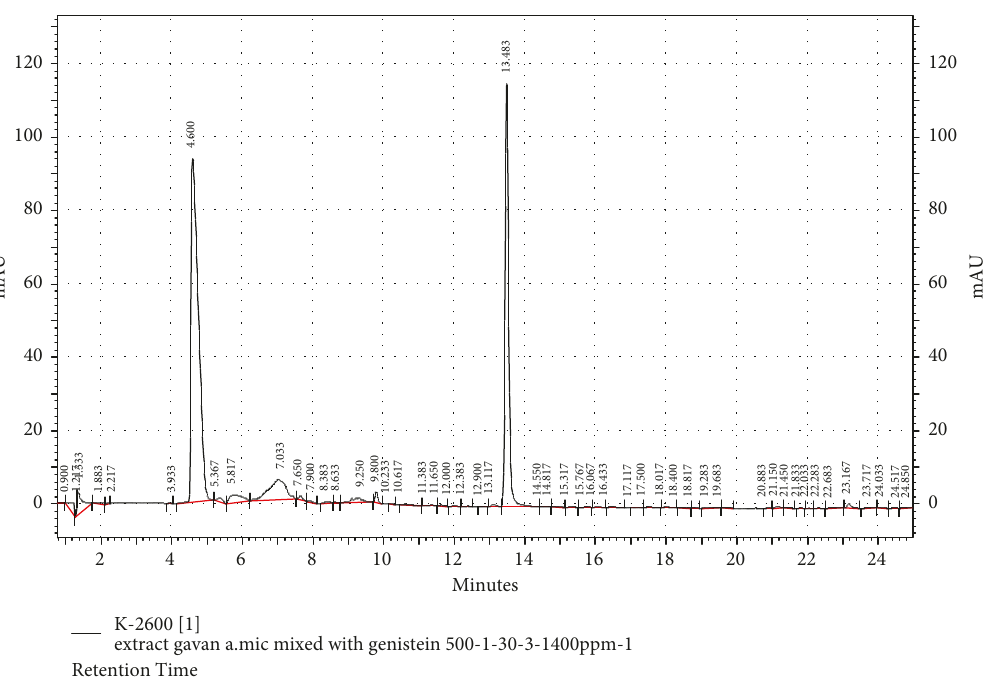
Figure 3: The HPLC diagram of the standard genistein mixed with the extract. Retention time 13.483 corresponds to the peak of genistein. Table 1: The LC/MS peaks information, retention time (RT) values, [ M + H ] + , and concentration. Peak IDs RT (min) Recovery (%) m / z [ M + H ]+ Concentration ( μ g/g)